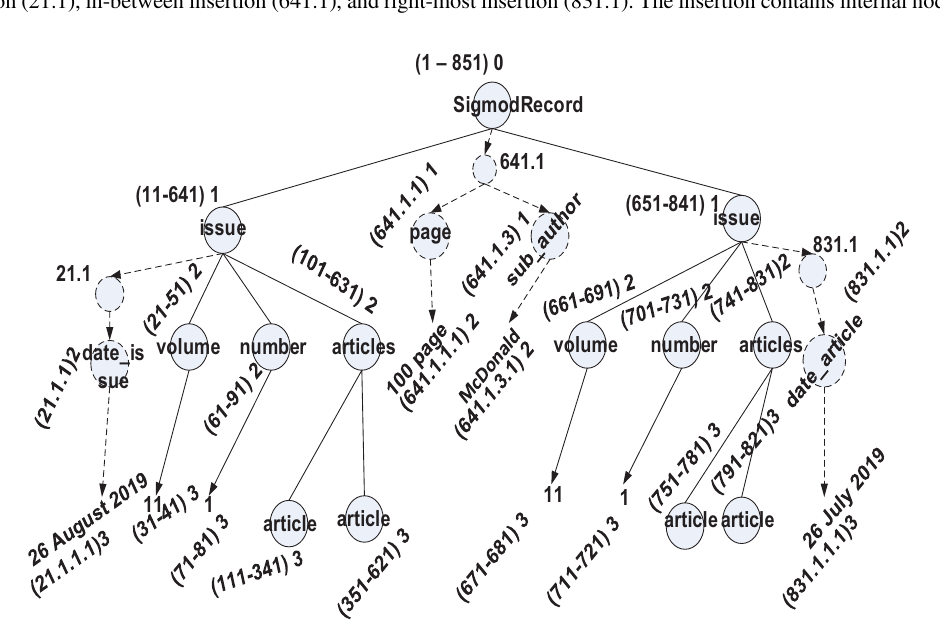
Figure 4. Left-most, in-between and right-most insertion on